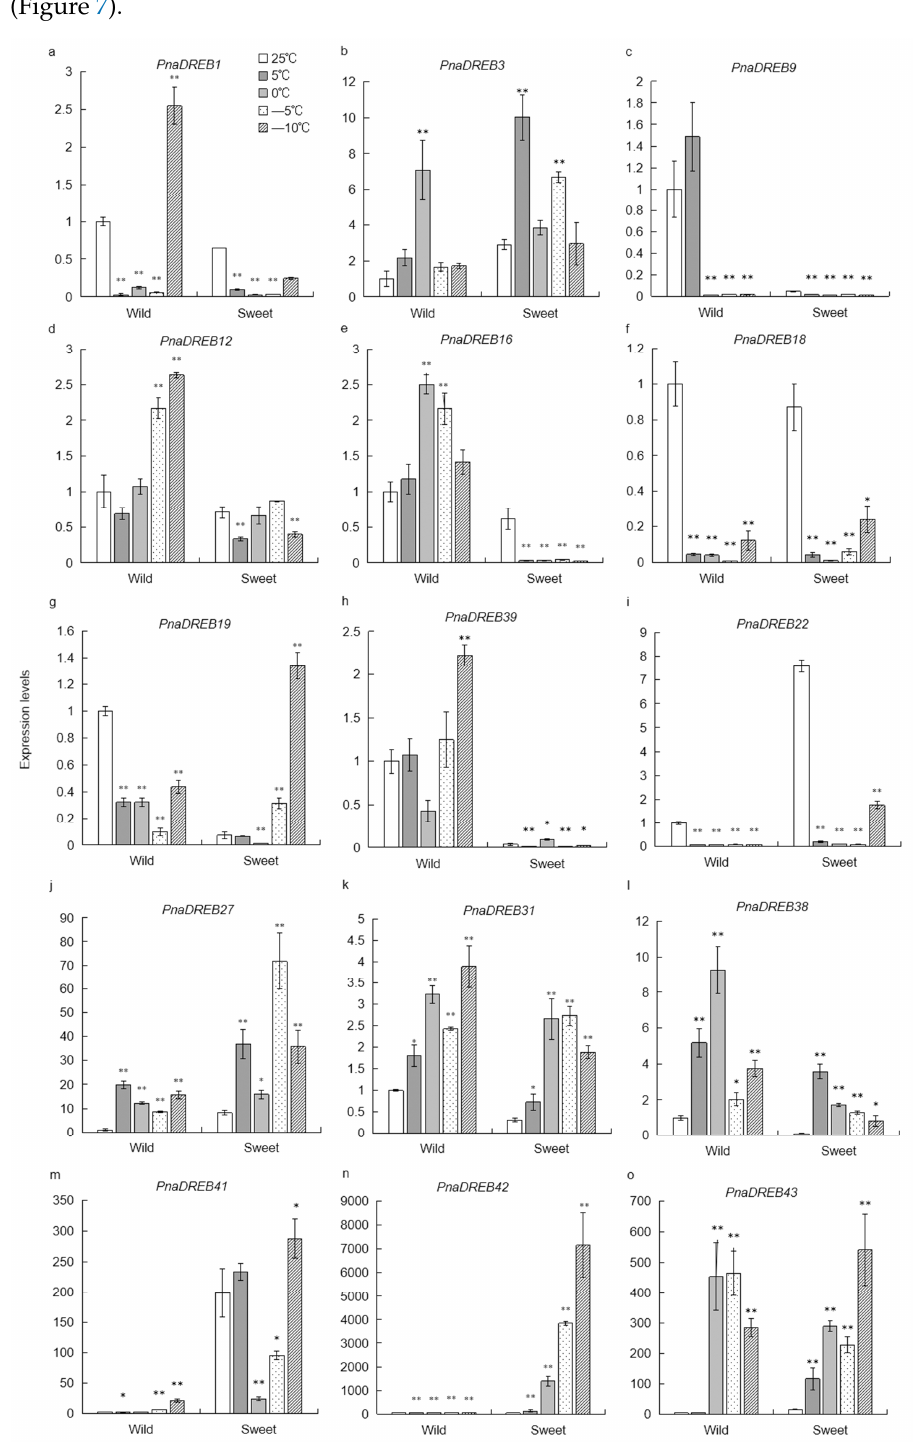
Figure 7. qPCR-based validation of PnaDREB expression patterns in plants subjected to low-temperature stress ( a – o ). Seedlings were subjected to 2 h treatment at 25 °C, 5 °C, 0 °C, − 5 °C, or − 10 °C. Mean expression levels are based on three replicate samples, and are presented with standard deviation values. * and ** indicate significant differences between the experimental treatments and control treatment (according to Student’s t -test) at p < 0.05 and p < 0.01, respectively.